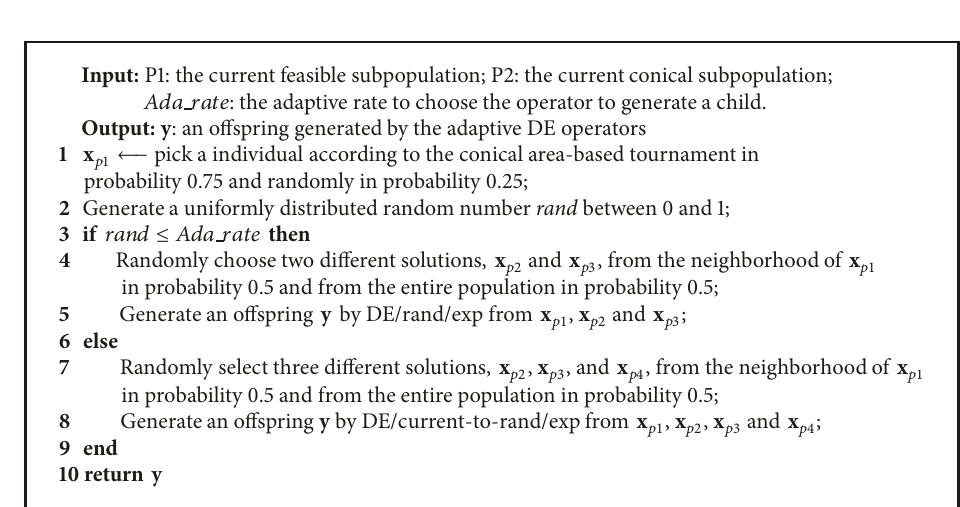
Algorithm 2: AssociateConicalSubpopulation